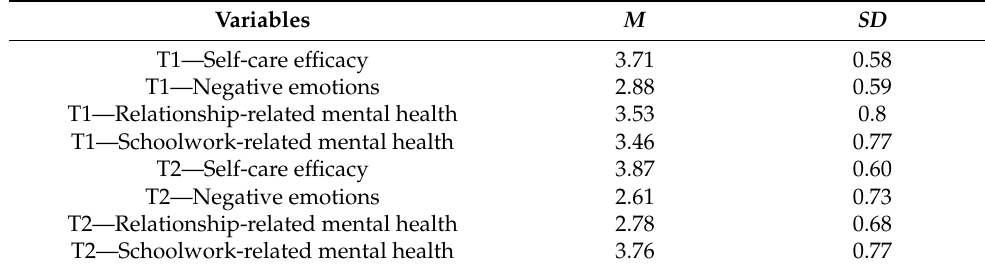
Table 1. Descriptive statistics of key